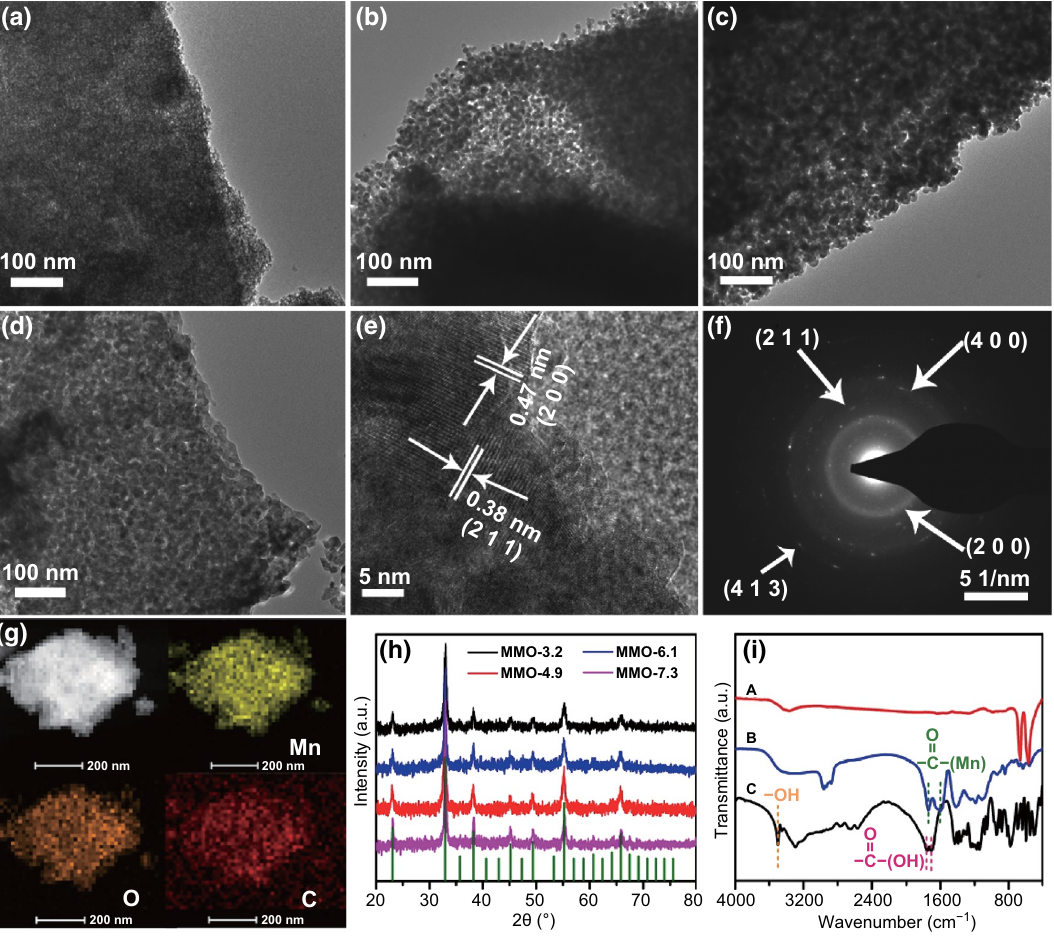
Fig. 2 Morphological and structural characterizations for mesoporous Mn 2 O 3 . TEM images of mesoporous Mn 2 O 3 synthesized at various con‑ centrations of Mn 2+ : a MMO‑3.2, b MMO‑4.9, c MMO‑6.1, d MMO‑7.3. e HRTEM images and f SAED patterns of MMO‑3.2. g TEM and elemental mapping of manganese, oxygen and carbon elements of MMO‑3.2. h XRD pattern of MMO with different pore sizes. i FTIR spectrum of MMO‑3.2 ( line A: Mn 2 O 3 obtained at 350 °C, line B: Mn 2+ coordinated with citric acid, line C: citric acid